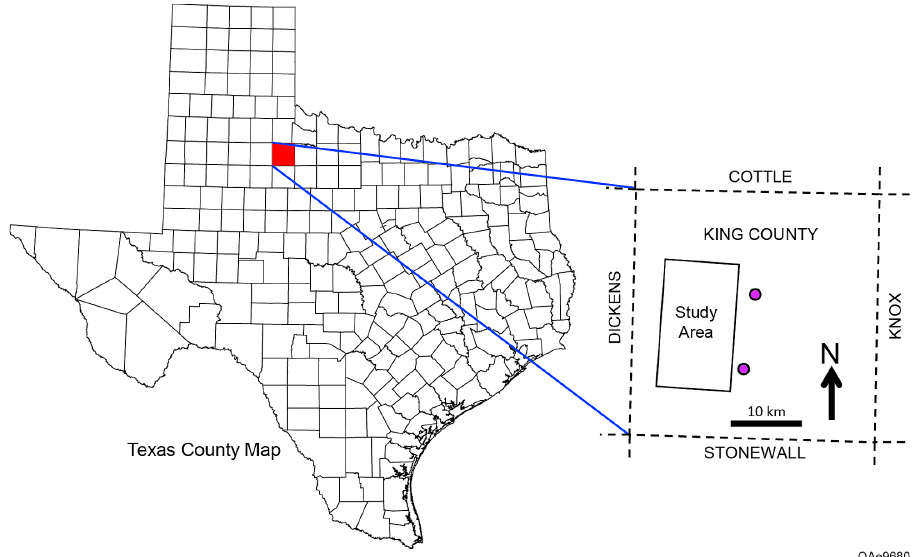
Figure 1. Location map of study area showing Texas county map, with King County highlighted in red (left panel). Dashed black rectangle (right panel) = enlarged version of red rectangle (King County) in left panel. Solid black rectangle = study area. Note: solid magenta circles = locations of core samples outside study area.